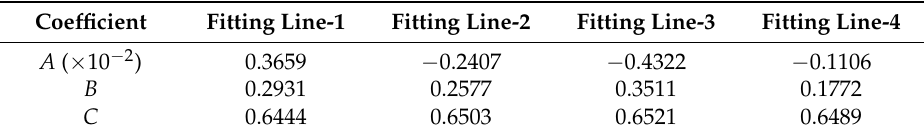
Figure 7. Number density of free volumes in each region of this model under tension, as well as the average value. The solid curves denote the fitting lines, which can be described by an exponential function. Table 2. The values of A , B , and C of all the fitting lines. All of the fitting lines can be expressed by an exponential function. A , B , and C are coefficients or constants of this exponential function. Fitting lines 1, 2, 3, and 4 correspond to the center, transitional, and marginal regions, and the average one, respectively.